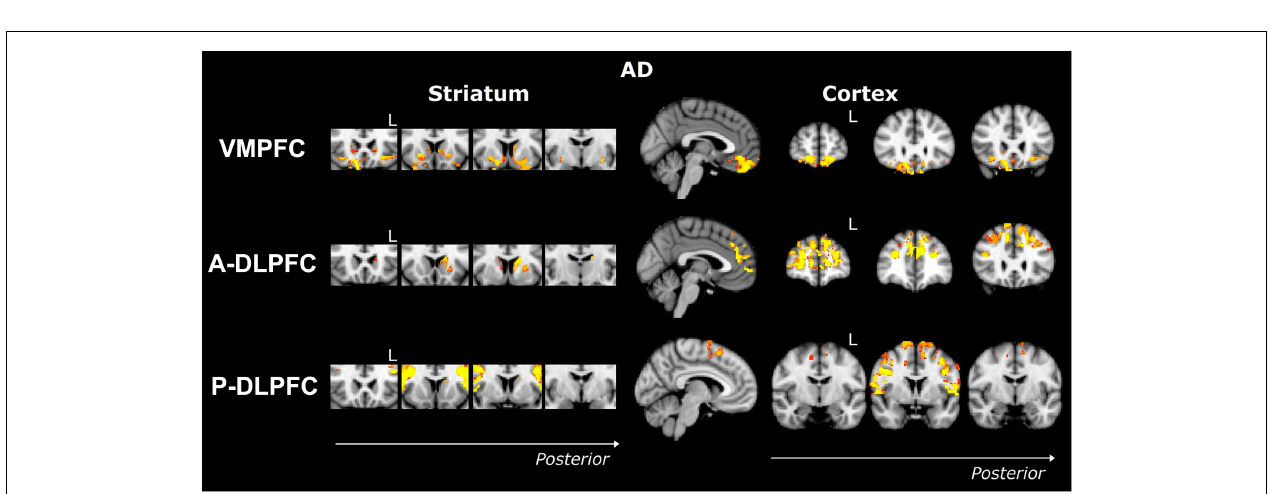
FIGURE 1 | Voxel-based morphometry analyses showing areas that were atrophic in bvFTD compared to controls for the three ROIs (VMPFC, A-DLPFC, and P-DLPFC), in striatum (left) and cortex (right) . Clusters are overlaid on the MNI standard brain. Colored voxels show regions that were